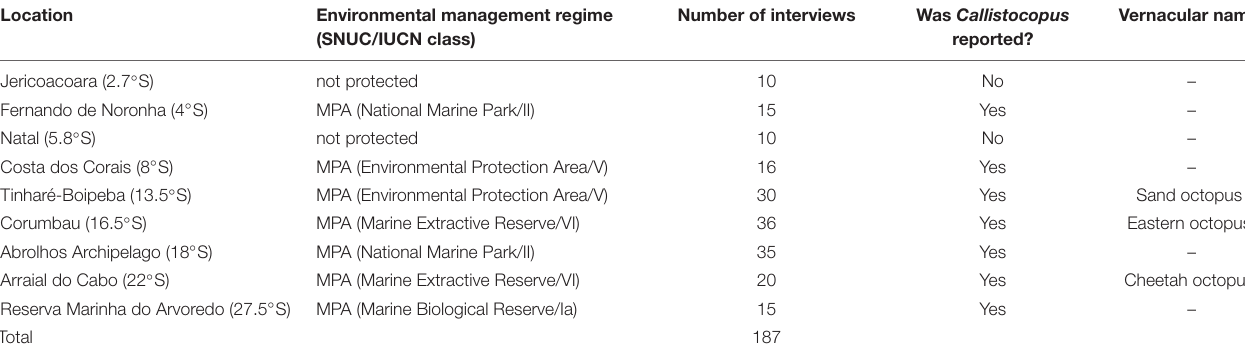
TABLE 1 | Summary of Callistoctopus ethnobiological survey areas, including protected and unprotected locations.